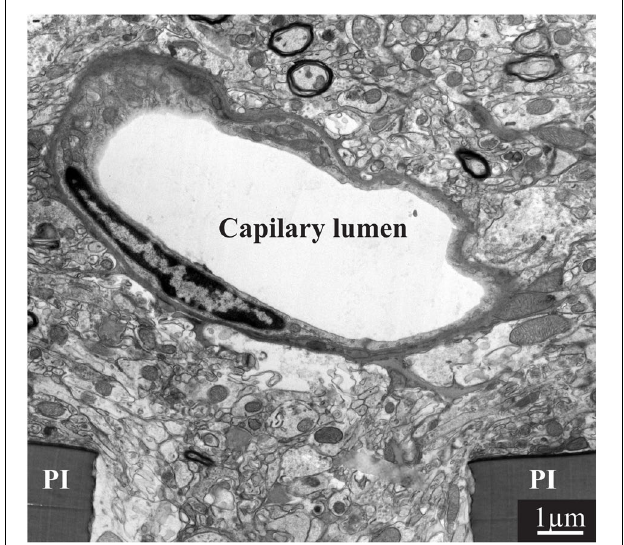
FIGURE 8 | Regeneration of capillaries close to implanted PPMPs. A capillary located micrometers away from the surface of the polyimide (PI) “ribs” of an implanted PPMP for 8